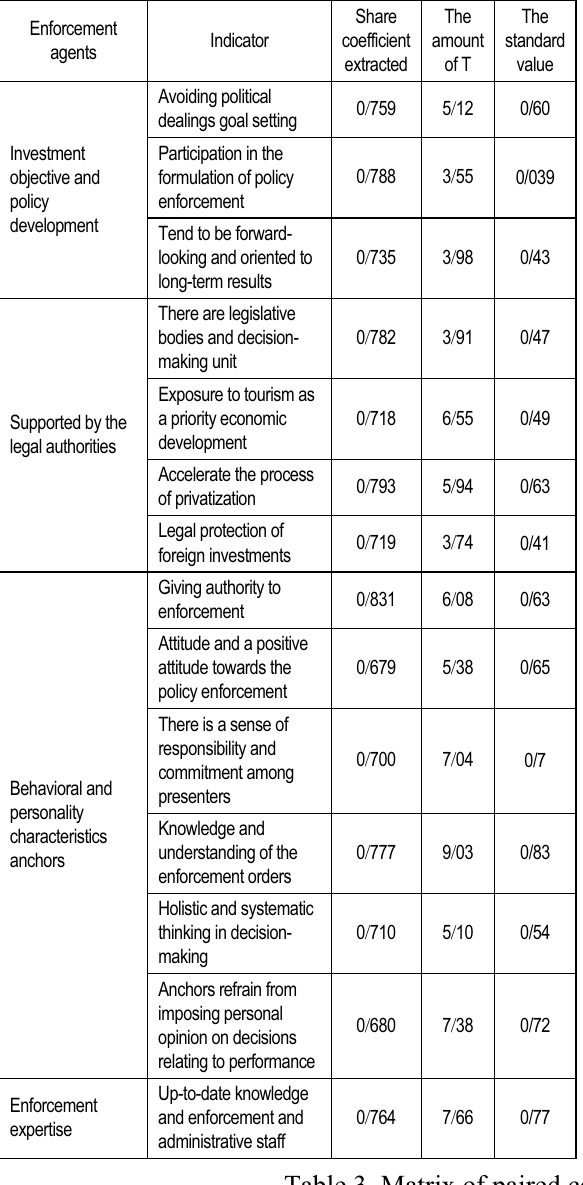
Table 2 (cont.). Index values confirmatory factor analysis extracted and enforcement